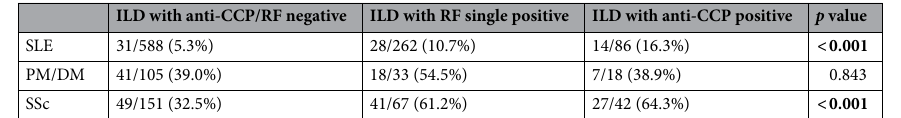
ILD with anti-CCP/RF negative ILD with RF single positive ILD with anti-CCP positive p